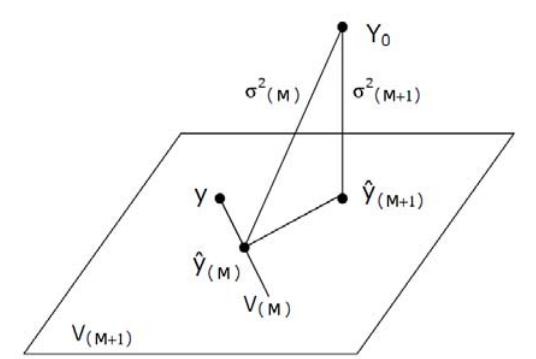
Figure 1. Geometric interpretation of the significance analysis of a new